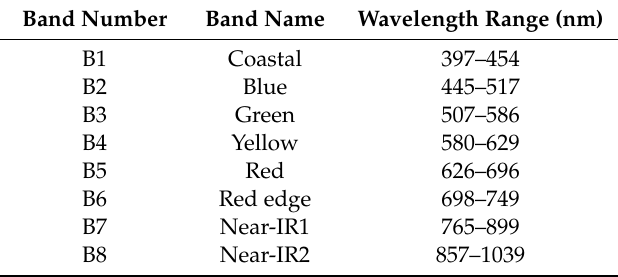
Table 1. Eight multispectral bands of the WorldView-3 remote sensing image